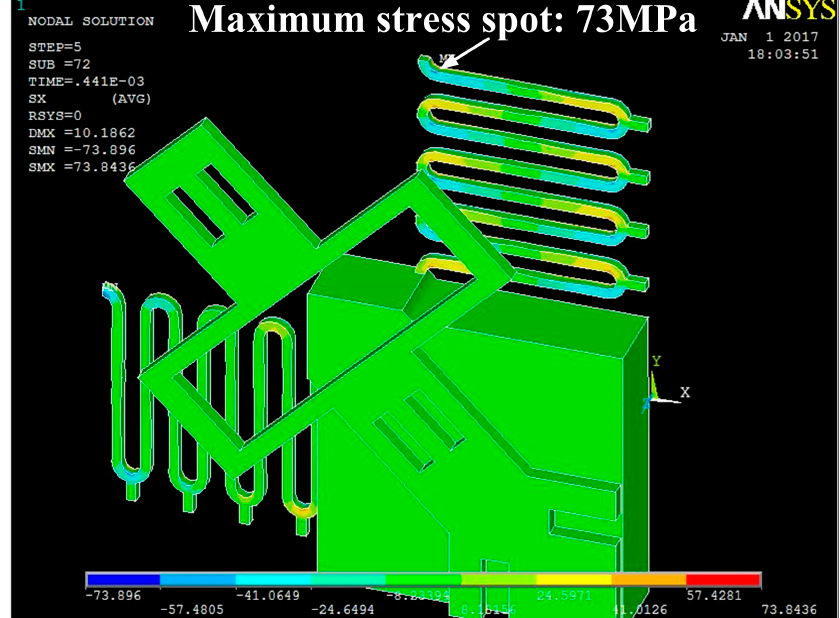
Figure 6. The maximum stress distribution of the serpentine springs and the stationary electrode of sample 1 under the applied acceleration 288 g.